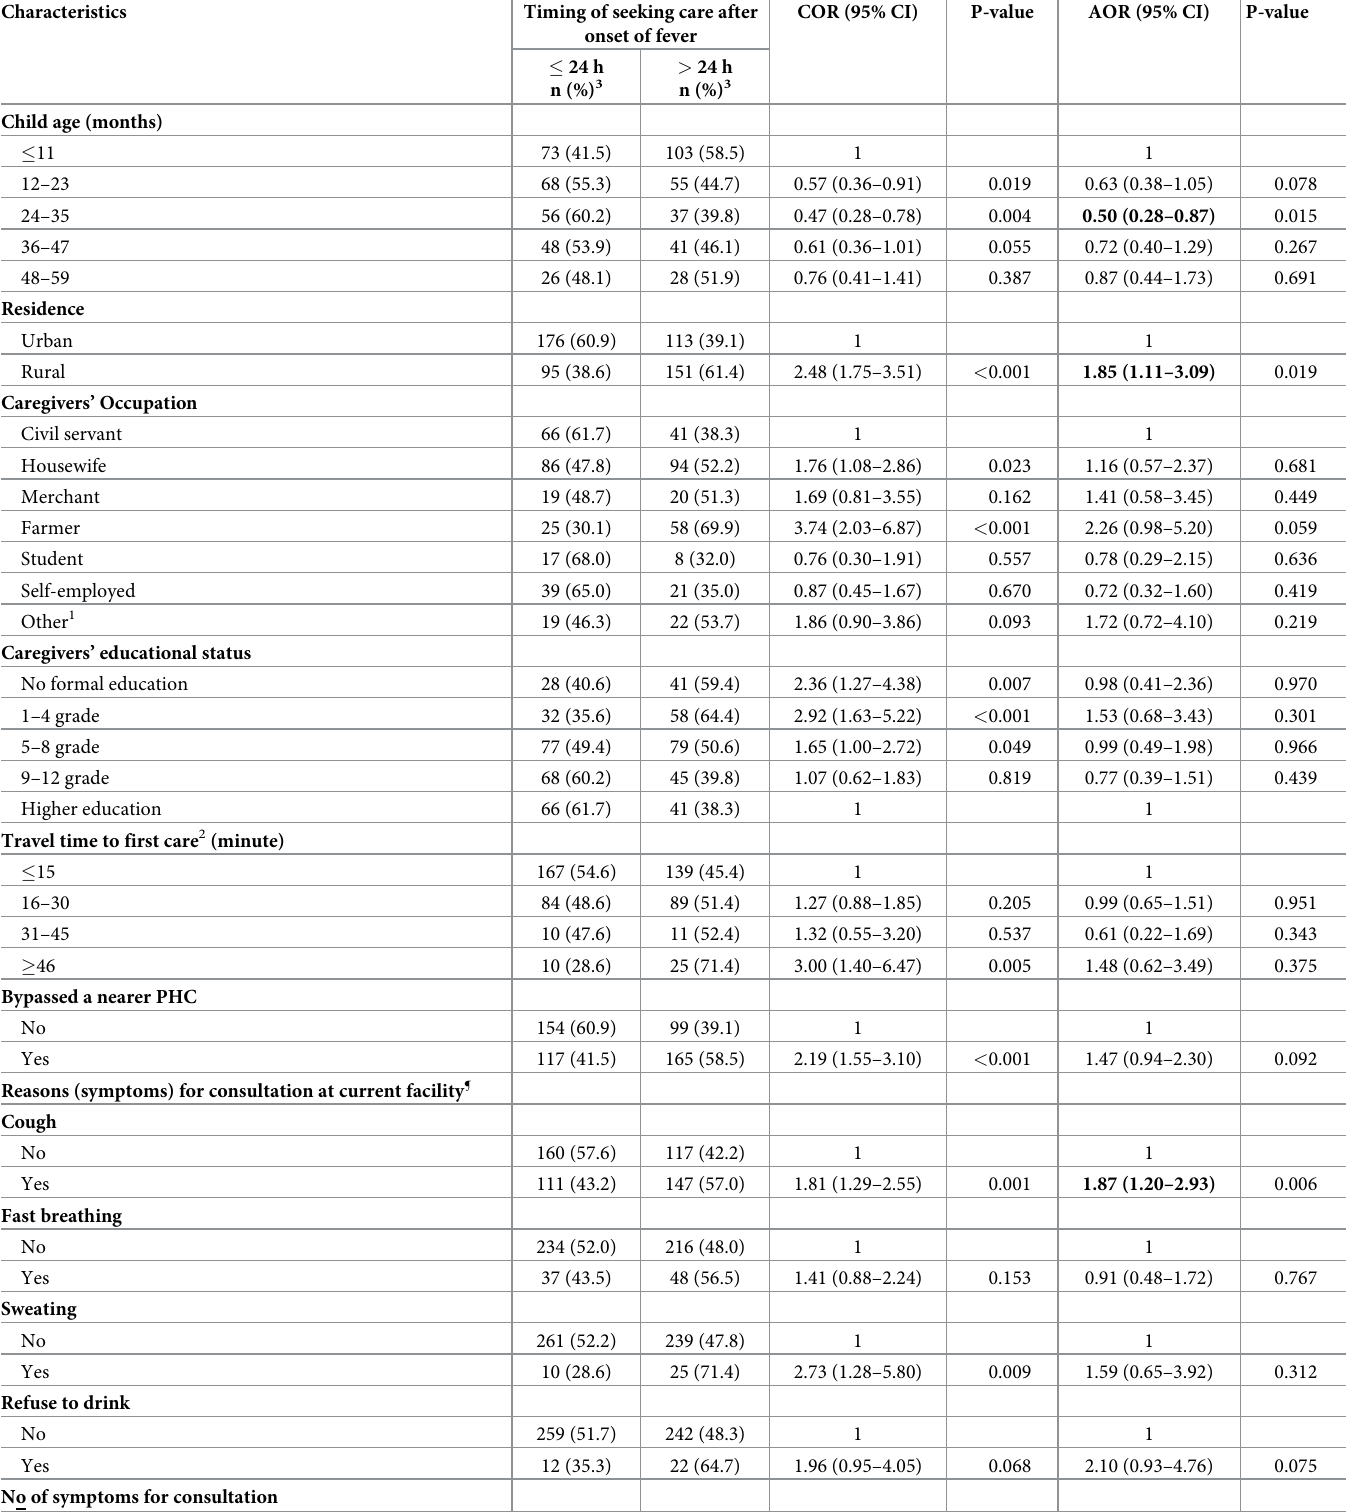
Table 2. Factors influencing the odds of delayed (after 24 hours of onset of fever) in health care seeking for febrile children in Hawassa City, 2019 (N = 535).